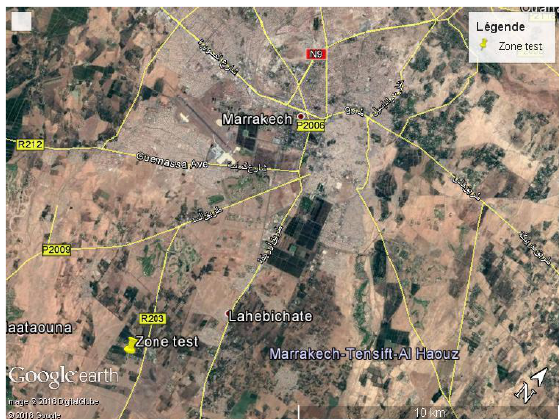
Figure 1 . Location of the study area (Google Earth,